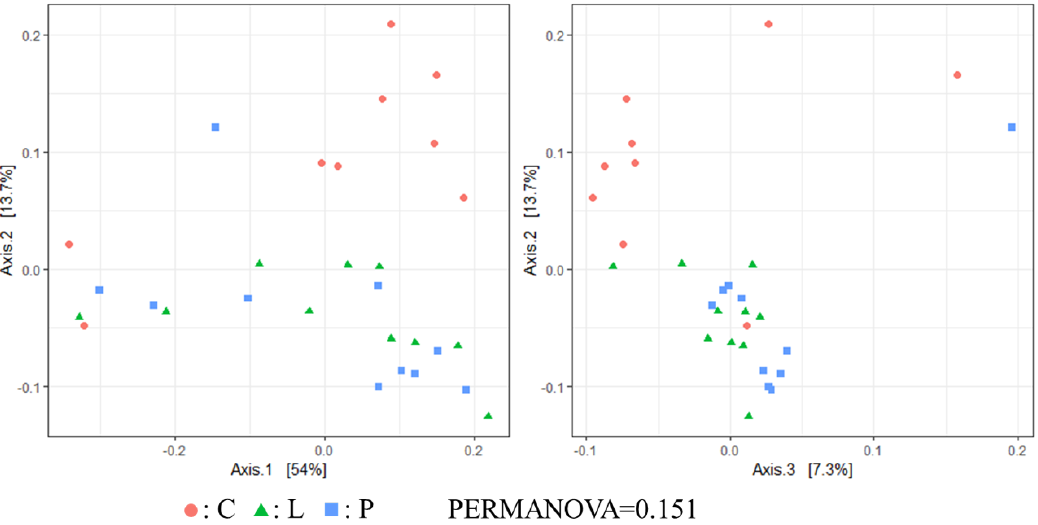
Figure 3. Microbial communities in the gut of experimental hens collected after 5 weeks of BSF larvae and pre-pupae dietary supplementation (C: n = 9; L: n = 10; P: n = 10). Weighted UniFrac distance principal coordinate analysis (PCoA) plots of β -diversity measurement of the microbiota communities. C: control diet; L: larvae diet; P: pre-pupae diet.